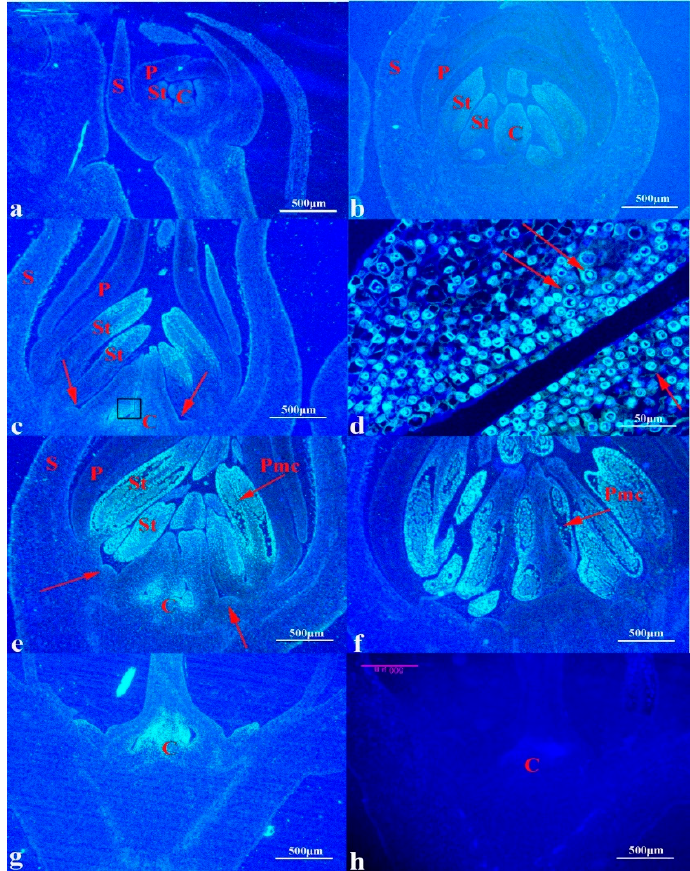
Figure 5. Terminal deoxynucleotidyl transferase-mediated dUTP nick-end labeling (TUNEL) staining of male floral buds during differentiation in persimmon. ( a , b ) Pistil-specific DNA damage became detectable at the carpel primordium differentiation stage in plants harvested on April 5, 2017 and at the anther primordium differentiation stage in plants harvested on April 8, 2017. ( c ) Dead cells reached a height in the carpel primordium in plants harvested on April 11, 2017. ( d ) Image of the carpel from the rectangle magnified in ( c ) (arrows indicate dead cells). ( e ) Pistil primordium harvested on April 14, 2017 at the microsporocyte stage showed strong positive staining and signs of PCD changes. ( f ) The dead cells of pistil primordium harvested on April 17, 2017 were almost invisible. ( g ) Positive control of the pistil primordium in male flower buds harvested on April 11, 2017, where nuclei were evenly stained after DNase treatment prior to the TUNEL assay. ( h ) Negative control of the pistil primordium in male flower bud harvested on April 11, 2017, where no observable TUNEL signals were observed. (C = carpel; P = petal; Pmc = pollen mother cell; S = sepal; St = stamen).